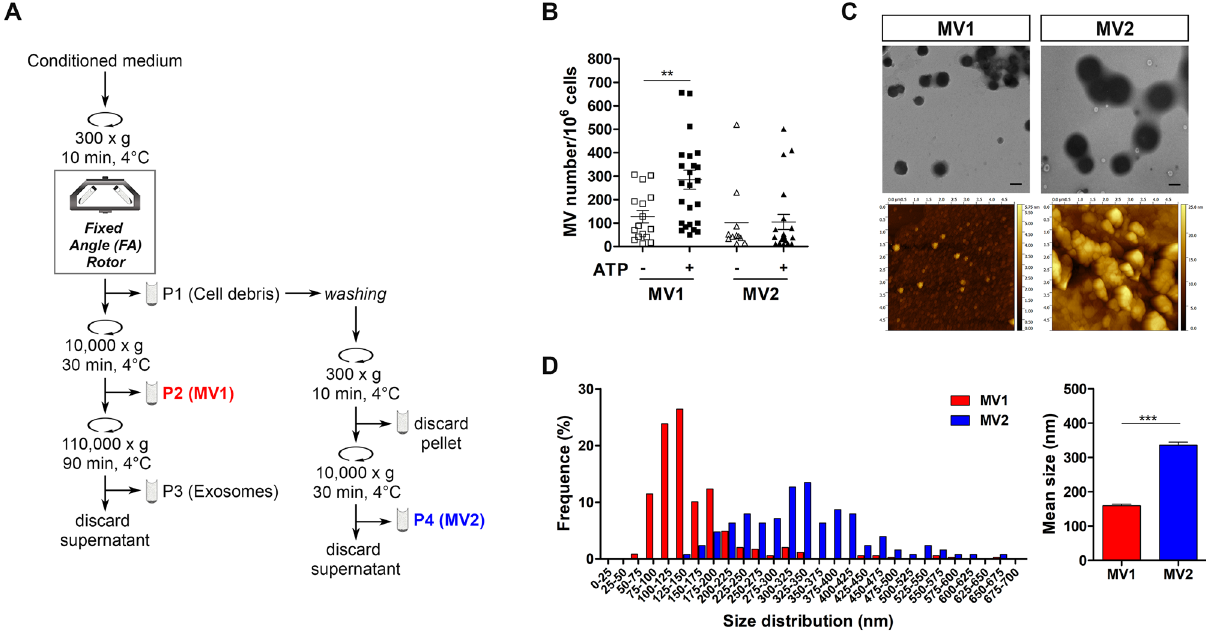
Figure 2. An additional washing step of the first discarded pellet enables isolation of a supplemental share of MVs from microglia cells. ( A ) Flow chart of an optimized differential centrifugation protocol including the additional washing step at the P1 pellet followed by a second MV isolation round. ( B ) Quantification of IB4/ Annexin V + MVs recovered in MV1 and MV2 fractions as measured by flow cytometry. Data are reported as mean ± SEM, ** p < 0.01, unpaired t-test (GraphPad Prism, version 5). ( C ) Transmission electron microscopy (TEM) and atomic force microscopy (AFM) of MV1 and MV2 collected fractions released from ATP-stimulated CHME-5 cells. Scale bars 200 nm. ( D ) Size distribution (left panel) and mean size (right panel) of MV1 and MV2 subpopulations determined from TEM image using Image J software (MV1 mean size of 159.4 ± 4.3 nm, n = 348; MV2 mean size of 335.4 ± 9.0 nm, n = 126). Data are reported as mean ± SEM, *** p < 0.001, unpaired t-test (GraphPad Prism, version